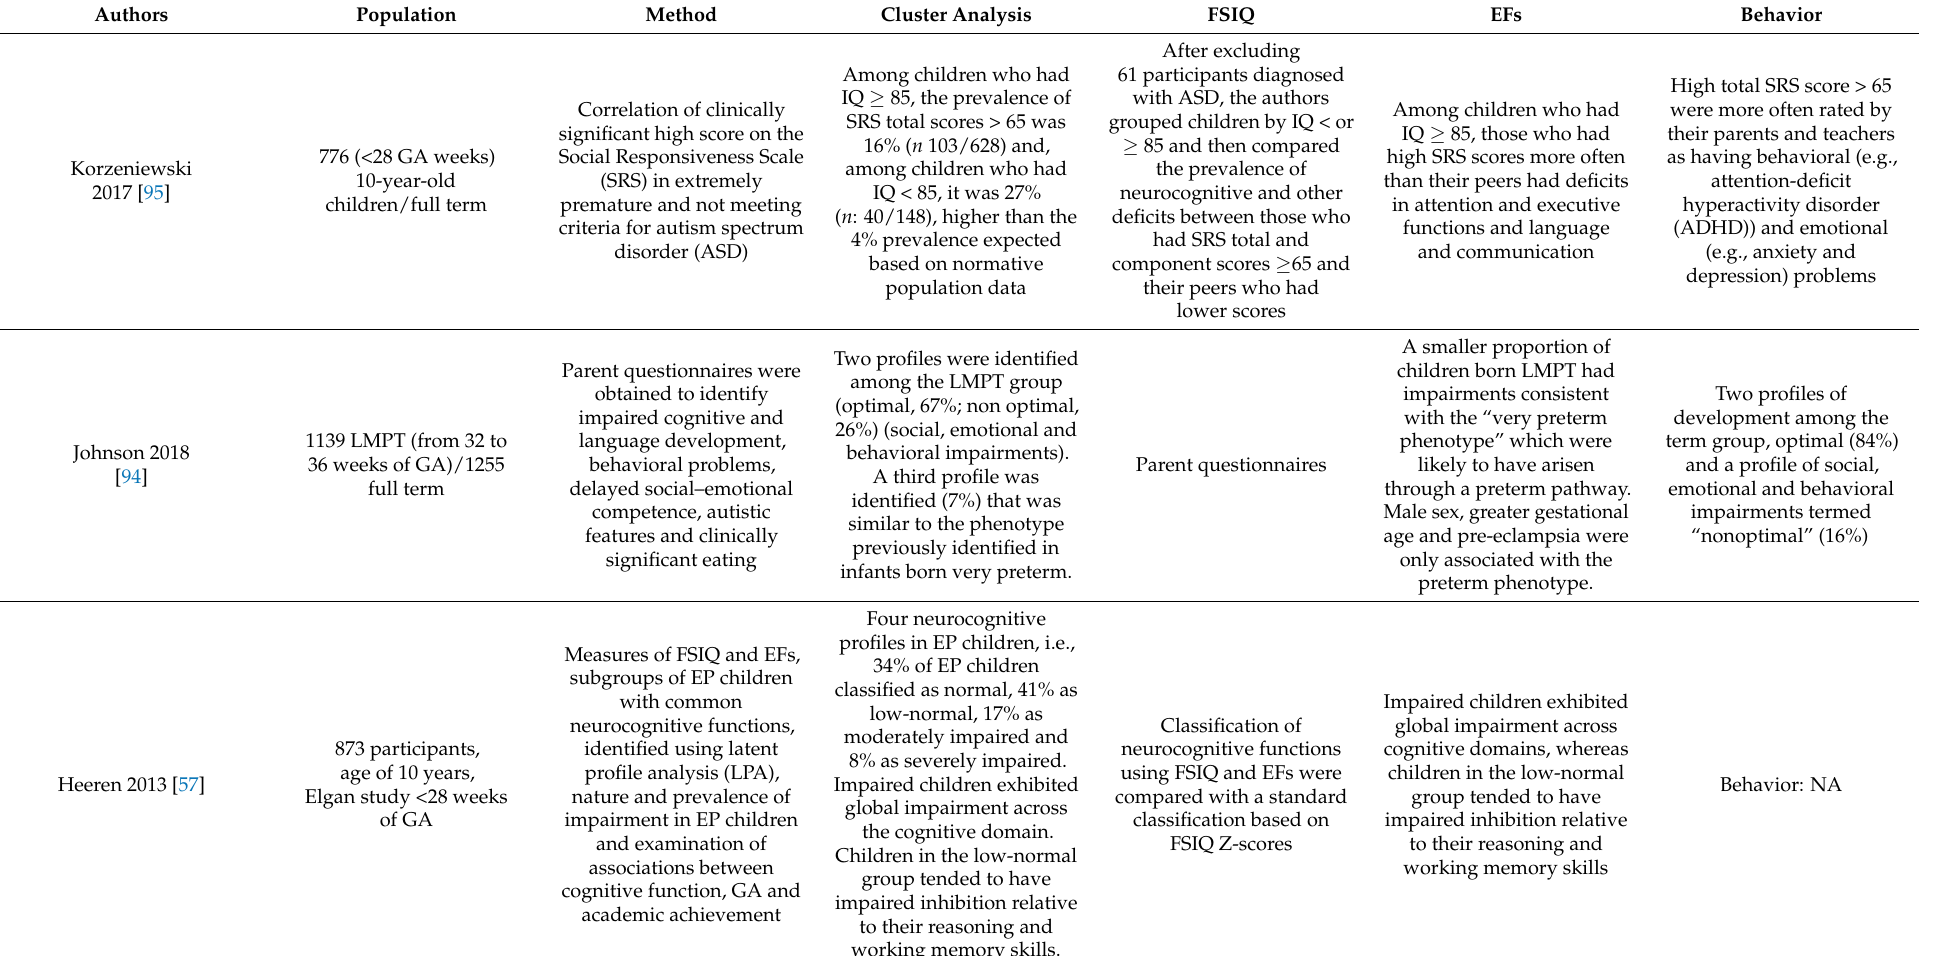
Table 1. Studies investigating the premature neurobehavioral